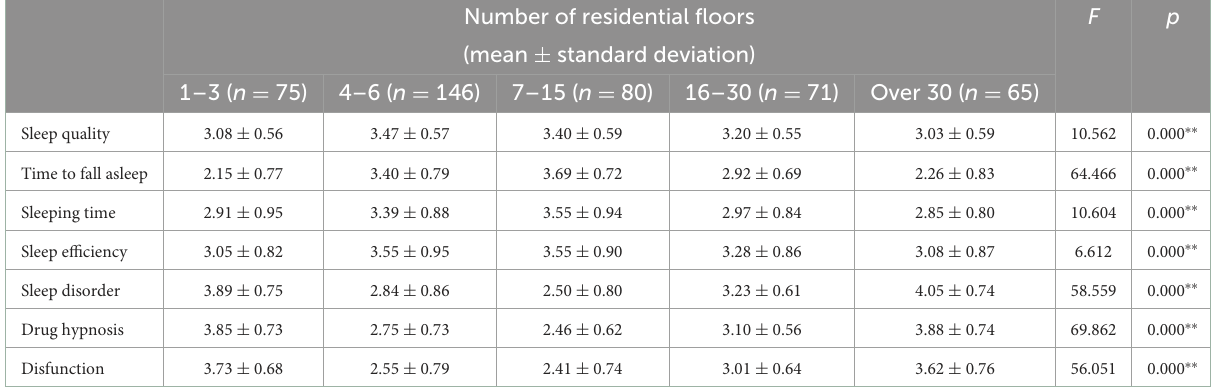
TABLE 4 Analysis of the variance results of different residential floors on residents’ sleep